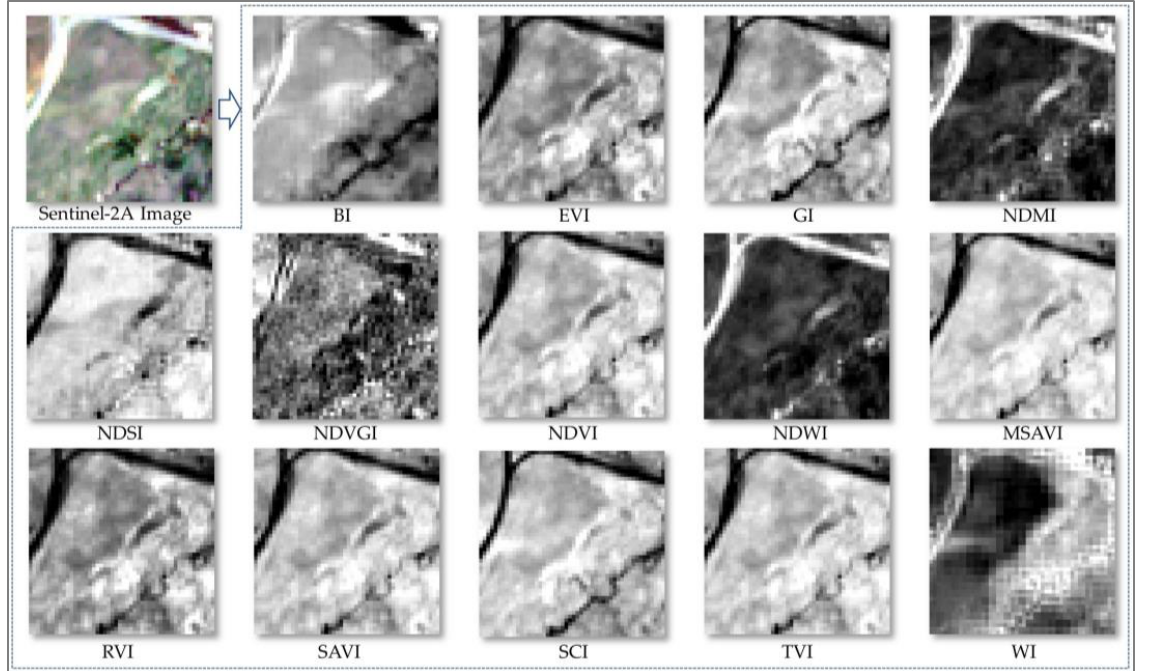
Figure 4. Fourteen spectral indices were calculated by band operation.